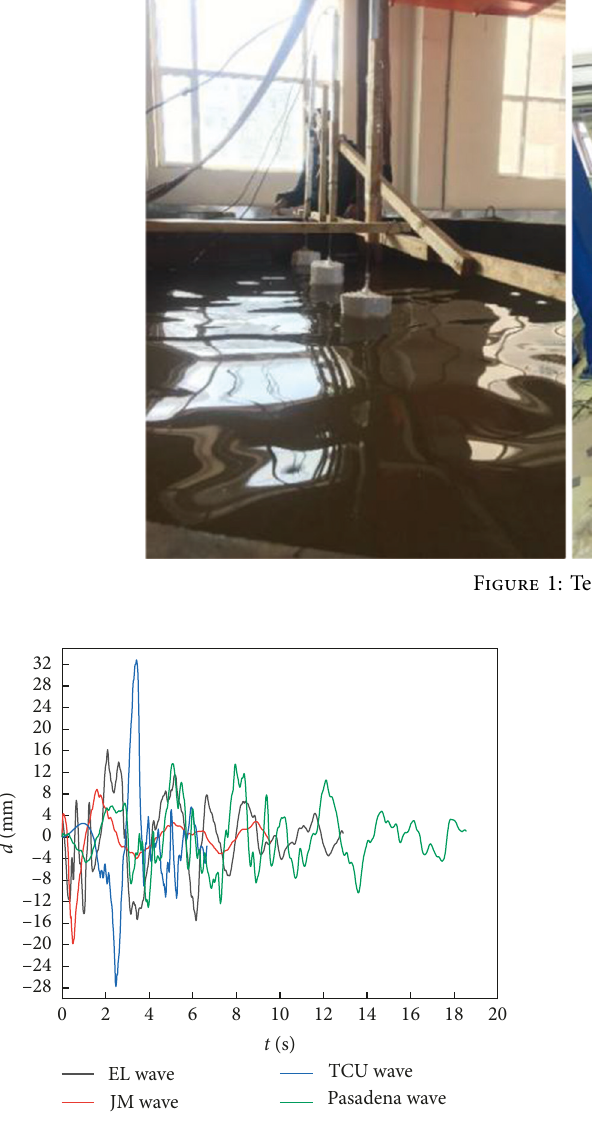
Figure 2: Seismic wave displacement time history diagram.